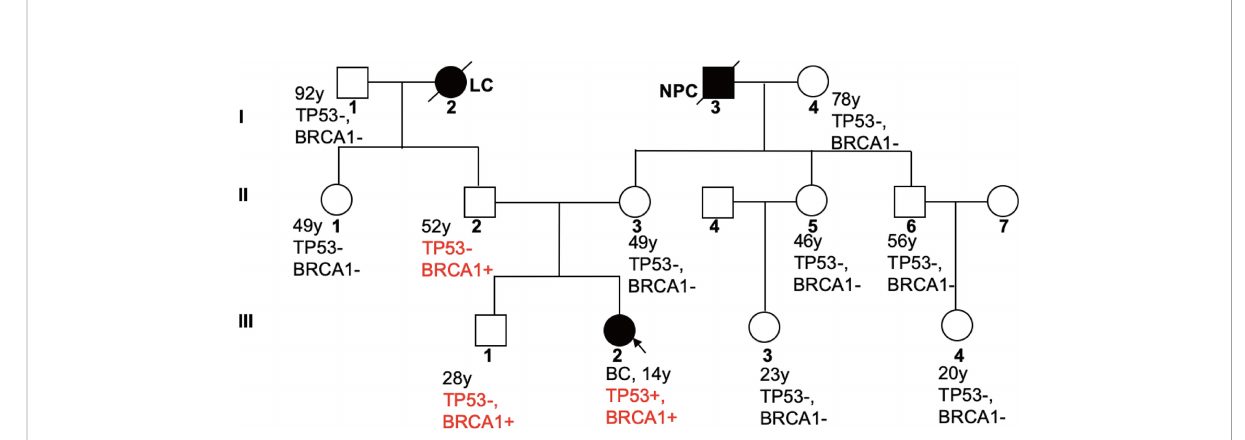
FIGURE 2 Familial Pedigree of case. The proband is indicated by an arrowhead. Squares represent males, circles represent females. Solid symbols represent affected individuals. Symbols with slash indicate deceased individuals. Age at cancer diagnosis is reported following the corresponding disease. LC, lung cancer; NPC, nasopharyngeal